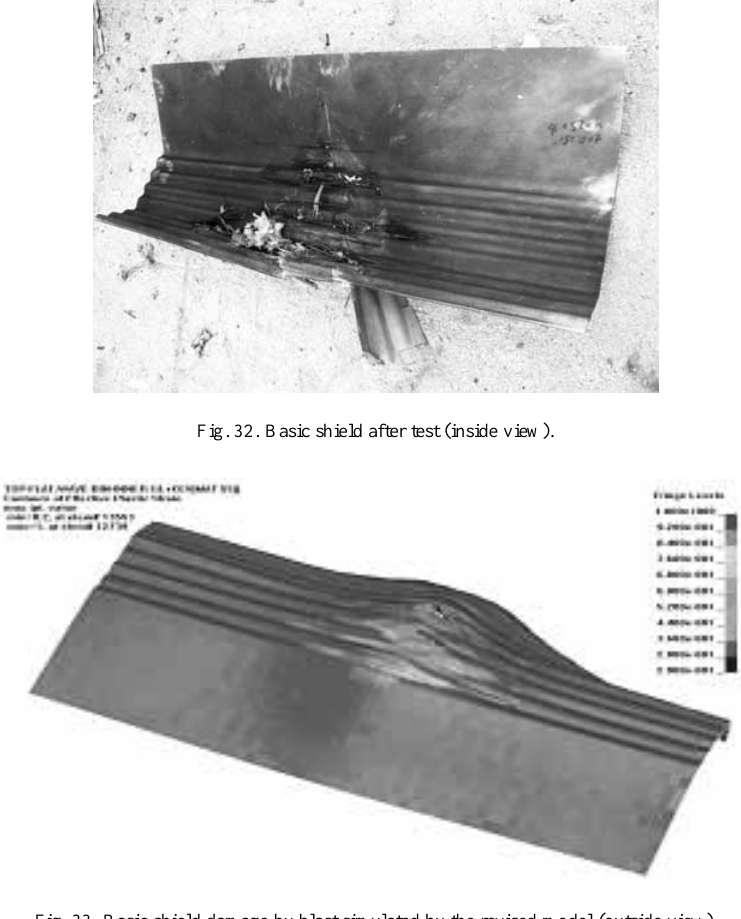
Fig. 33. Basic shield damage by blast simulated by the revised model (outside